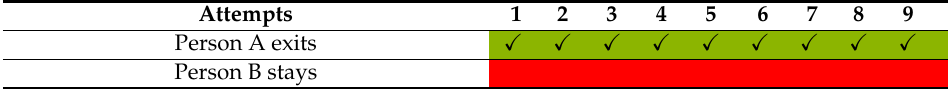
Table 9. One user exits; one user stays inside table of